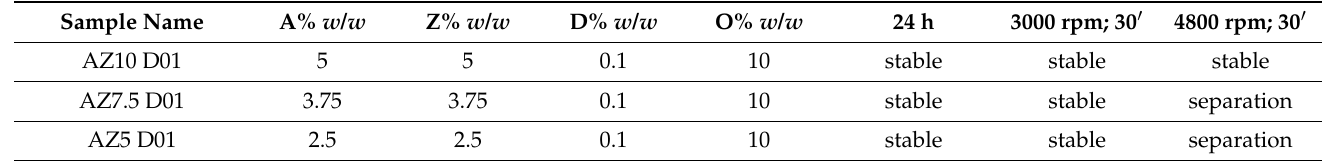
Figure 8. Storage G’ and loss G’’ moduli trend as a function of the oscillation strain measured for the emulsions prepared with A-Z associations (1:1) decreasing the total solid-phase amount (10–7.5– 5% w/w) with D at 0.1% w/w and 10% of oily phase.